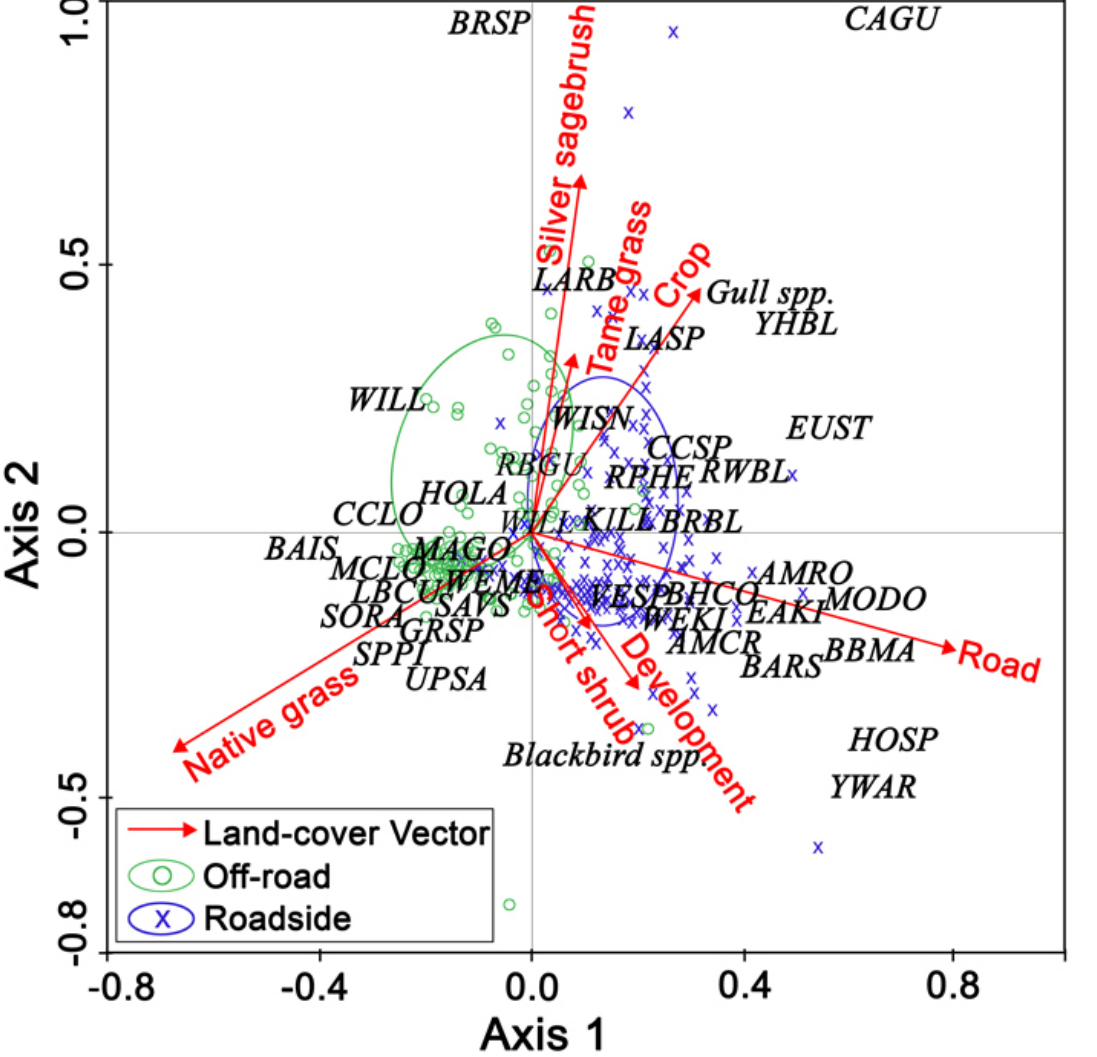
Fig. 2 . Canonical Correspondence Analysis (CCA) ordination plot with 67% confidence ellipses for 37 bird species plus two bird groups (Blackbird and Gull spp.), counted along off-road ( n = 225 point count stations) and roadside surveys ( n = 225 point counts), in the Prairie Ecozone of Alberta, Canada. Four-letter codes and scientific names for species are listed in Table 2. Vectors indicate direction and strength (length) of relationships between species and explanatory land-cover (habitat-type)